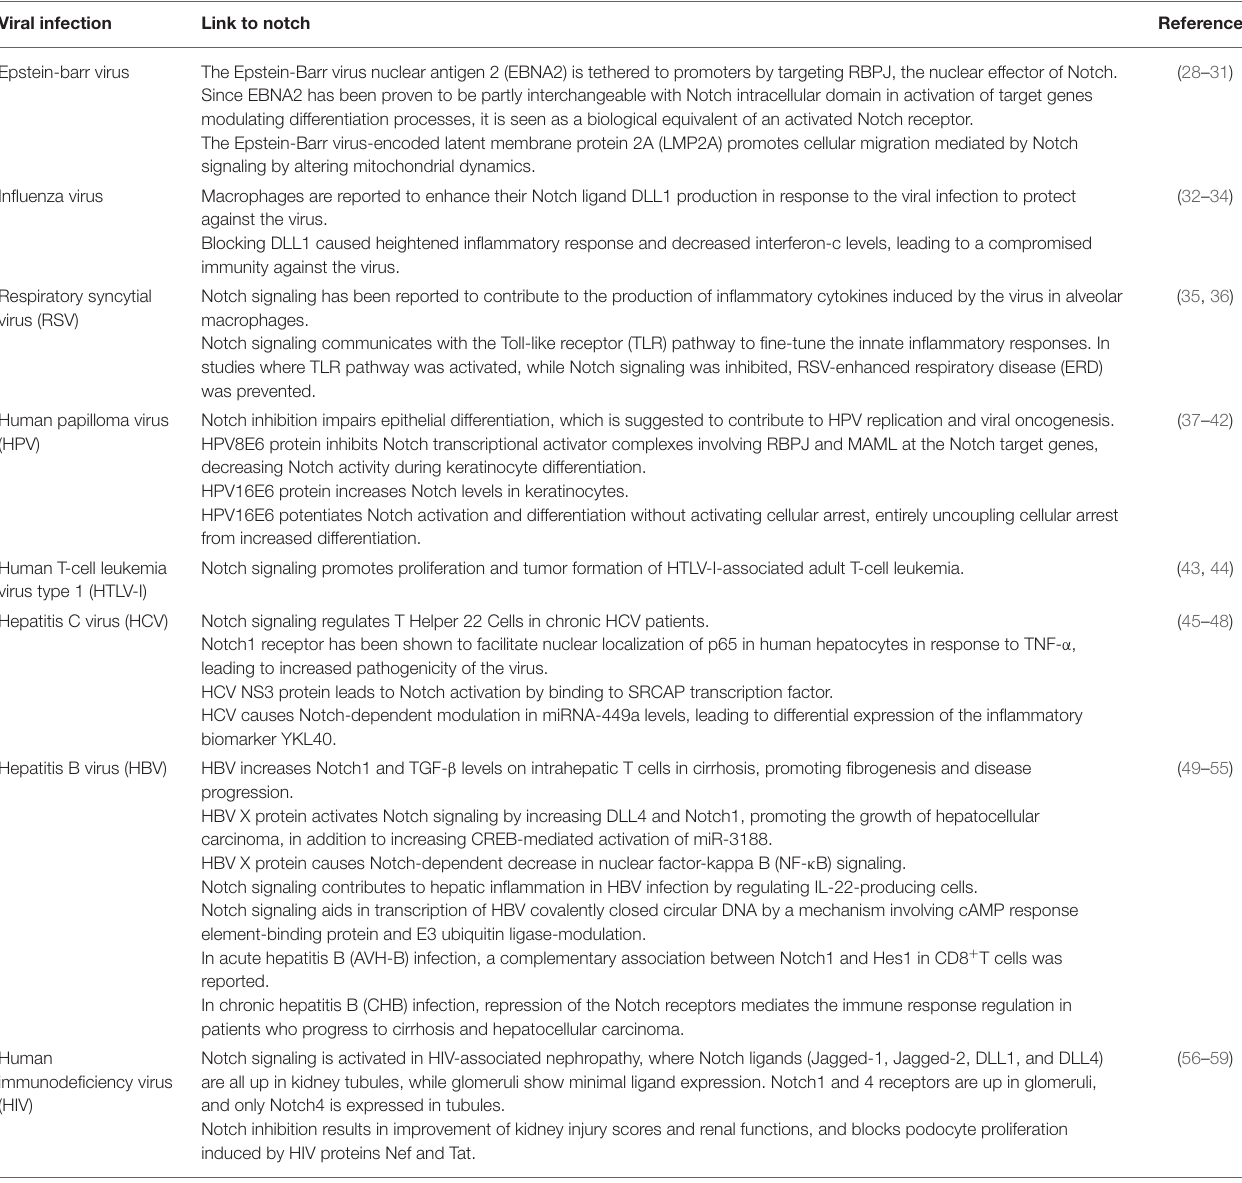
TABLE 1 | Reported link of the Notch signaling pathway to common viral